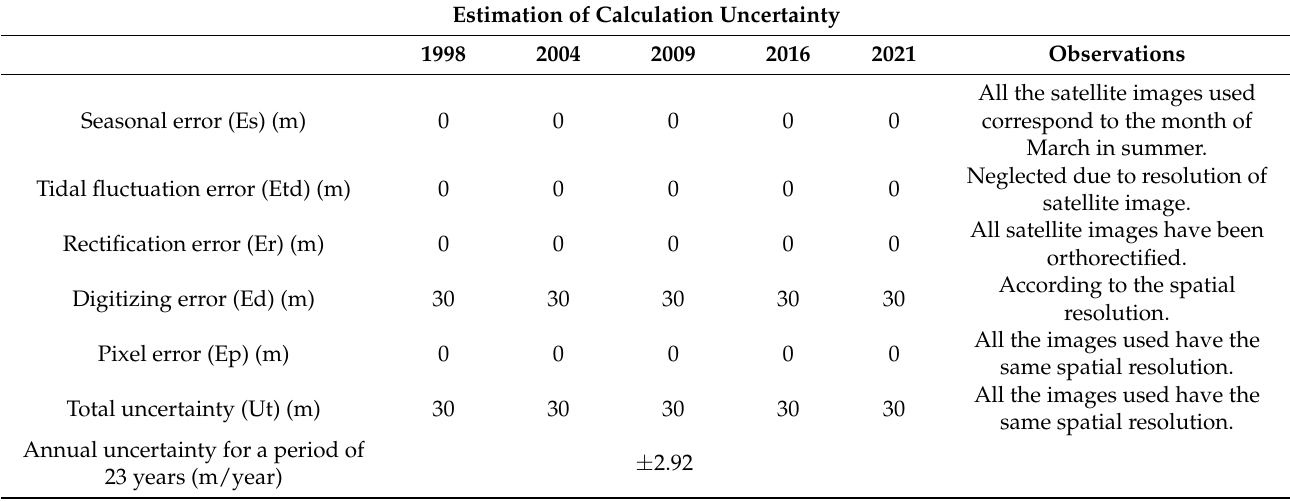
Table 4. Summary of uncertainty